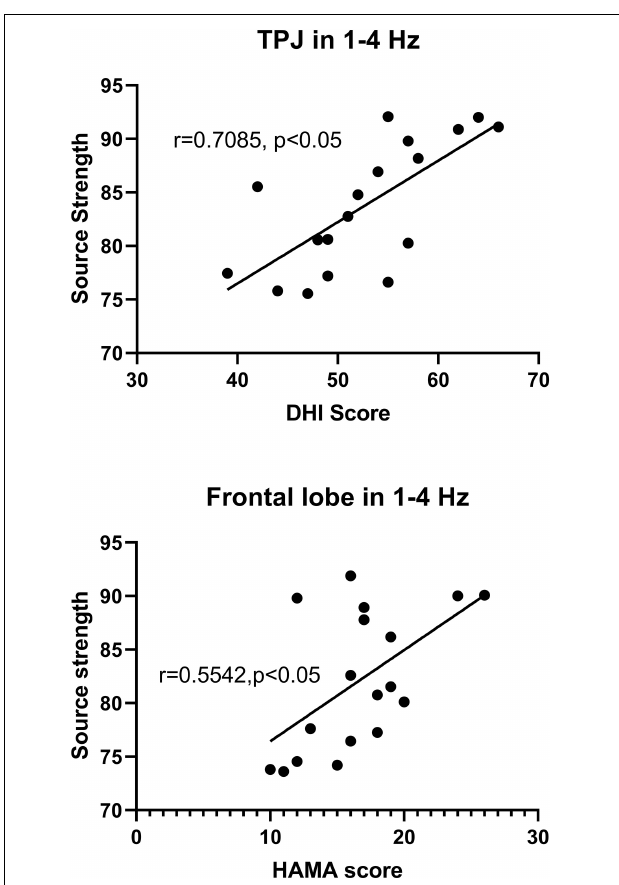
FIGURE 5 | The y -axis represents the neuromagnetic source strength. The x -axis represents clinical scores. Partial correlation analysis showed that the neuromagnetic source strength in TPJ in 1–4 Hz was positively correlated with DHI score ( r = 0.7085, p < 0.05), and the neuromagnetic source strength in frontal cortex in 1–4 Hz was positively correlated with HAMA score ( r = 0.5542, p < 0.05) after adjustment for sex and